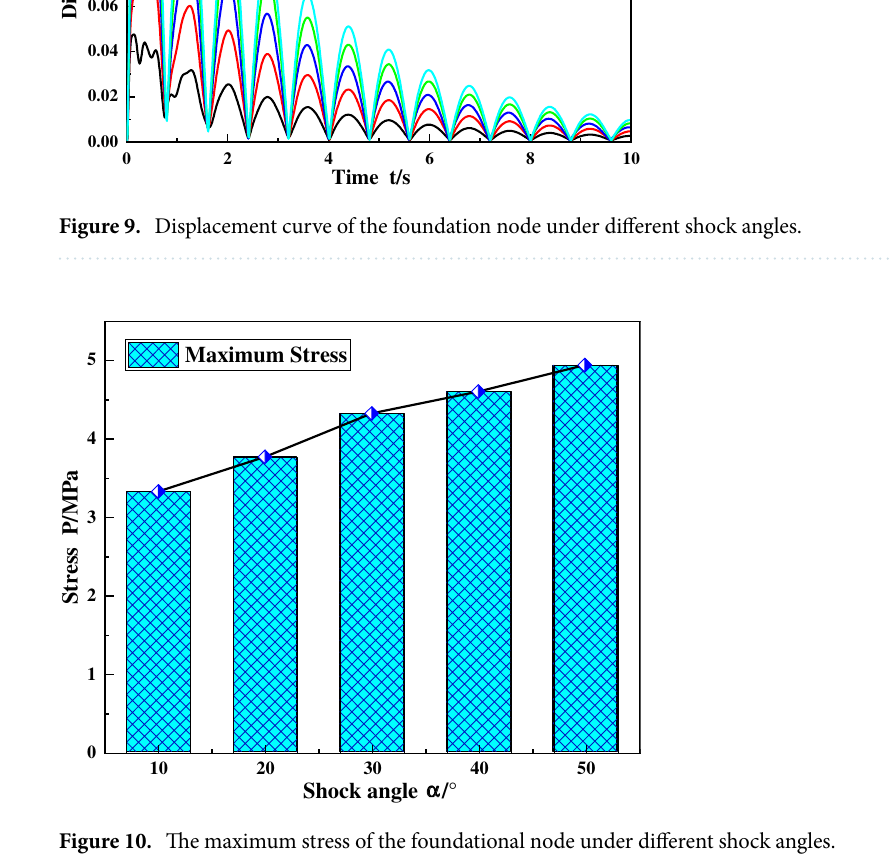
Figure 10. The maximum stress of the foundational node under different shock angles.